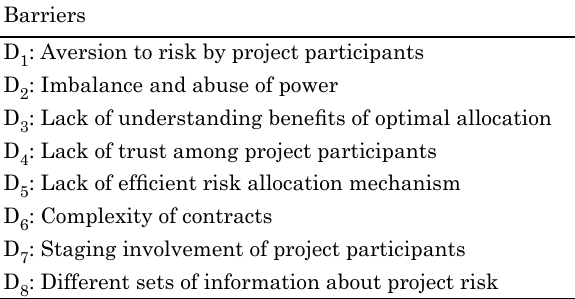
Table 6. Significant risk allocation barriers in Iranian PPP